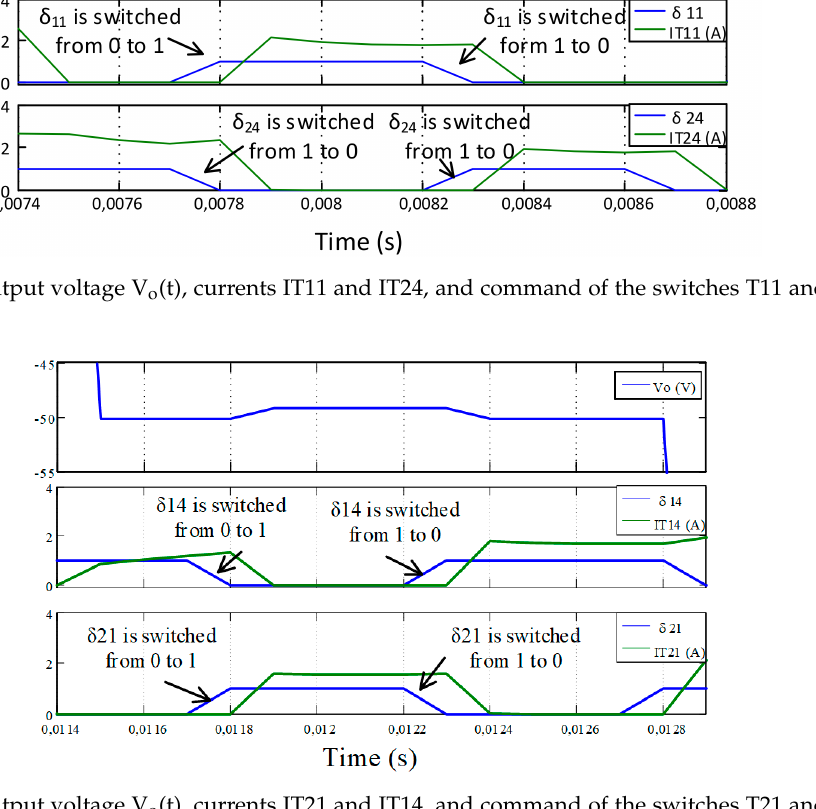
Figure 9. Output voltage V o (t), currents IT21 and IT14, and command of the switches T21 and T14 (Zoom 4). 3. The Principle of the Proposed OPT-PWM Strategy As mentioned before, several modulation strategies have been conventionally proposed in the literature to control the output voltage of multilevel inverters [17]. In this paper, to illustrate our contribution, the classical LS-PWM is considered and an additional block is proposed to provide a minimal number of commutations. Nevertheless, any conventional PWM method can be used ([1,8,15] and [24–27]), and the same modification of the modulation strategy we propose can be applied in all cases. Before discussing the OPT-PWM, it is necessary to define the following terms used in this paper: •